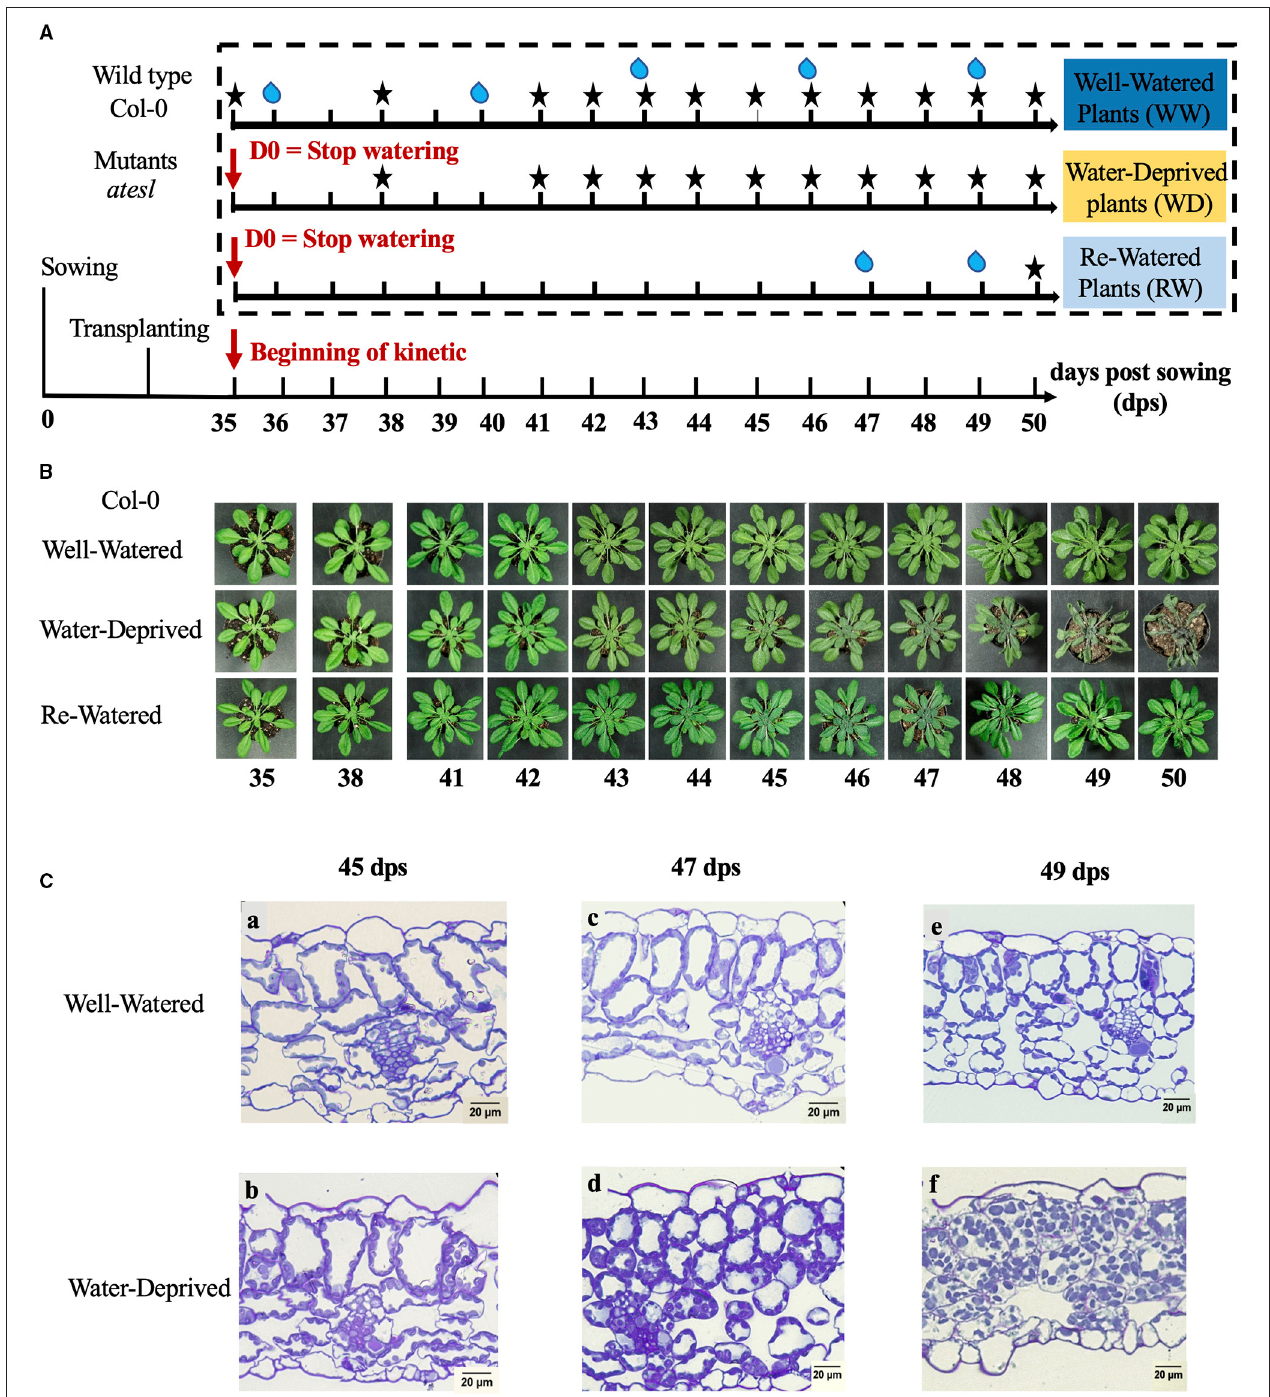
FIGURE 1 | Growth conditions, rosette phenotype, and leaves under microscopy observations of Arabidopsis thaliana . (A) Schematic representation of the different culture conditions of Col-0 and atesl mutants. WW, WD, and RW stand for well-watered, water-deprived, and re-watered, respectively. The days of watering are indicated by bleu drops and of harvest by black asterisks. (B) Development of Col-0 rosettes in WW, WD, and RW conditions during the 15 days of growth kinetics. (C) Light microscopy of Col-0 leaves cross-sections at the 45th (a,b), 47th (c,d), and 49th day post-sowing (dps) (e,f). The study was carried out with 10 plants per condition, and 3 independent biological repeats were performed ( ±